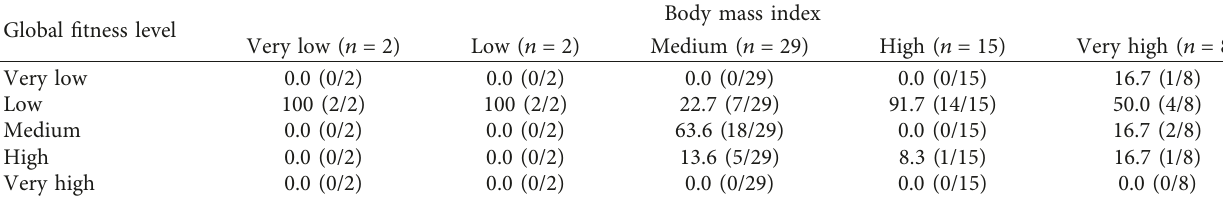
Table 4: Overall fitness level and its relation to BMI (%).